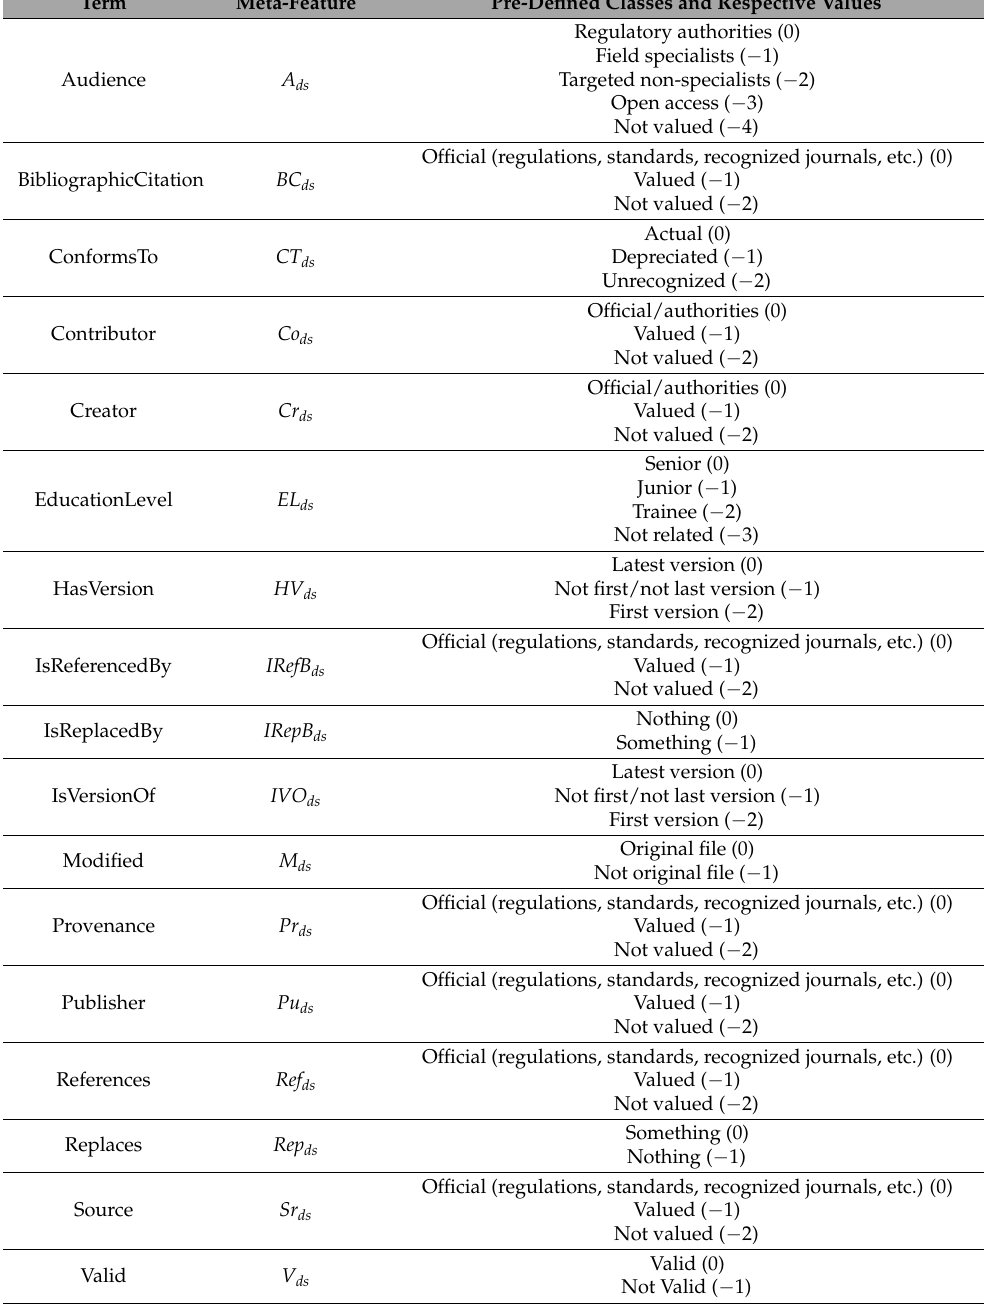
Table 17. Description and categorization of trust-related